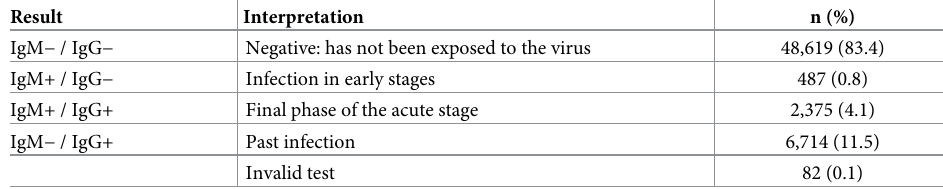
Table 3. Results of SARS-CoV-2 serological testing for IgG and IgM antibodies in asymptomatic subjects (N = 58,277).